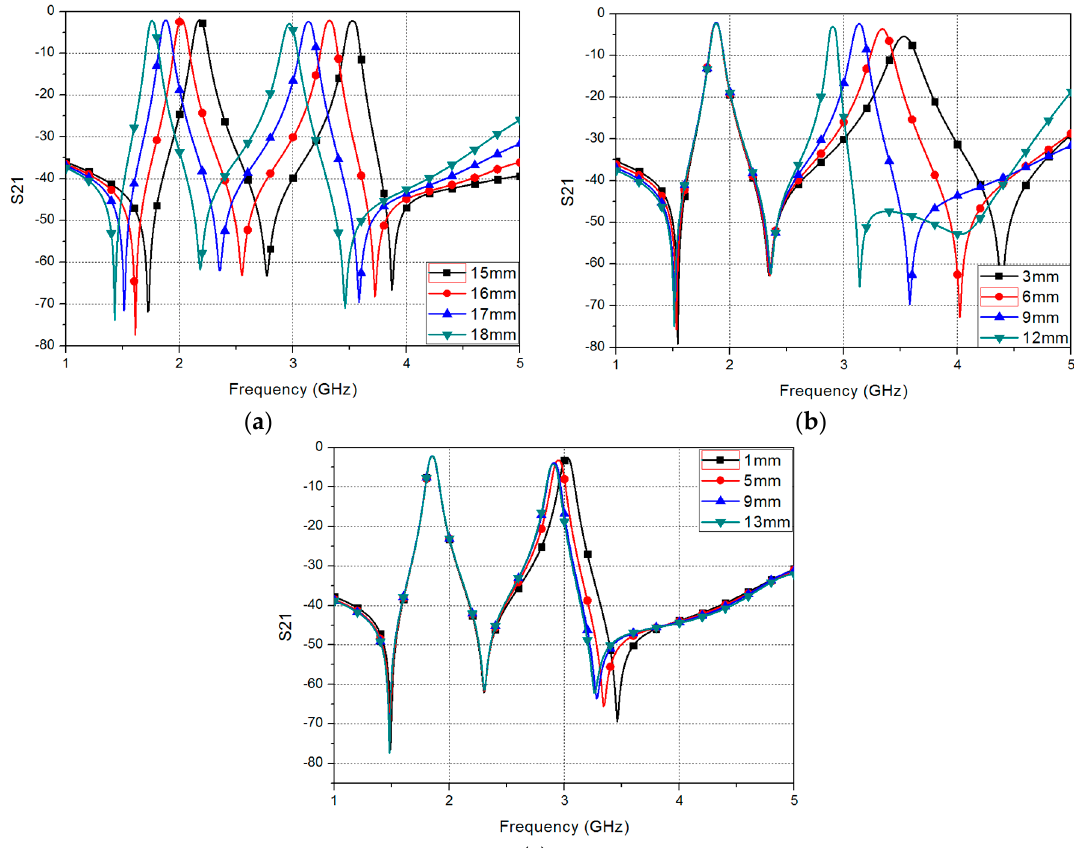
Figure 3. Simulated S 21 of the proposed filter for: ( a ) different L r ; ( b ) different L s ; and ( c ) different L c .